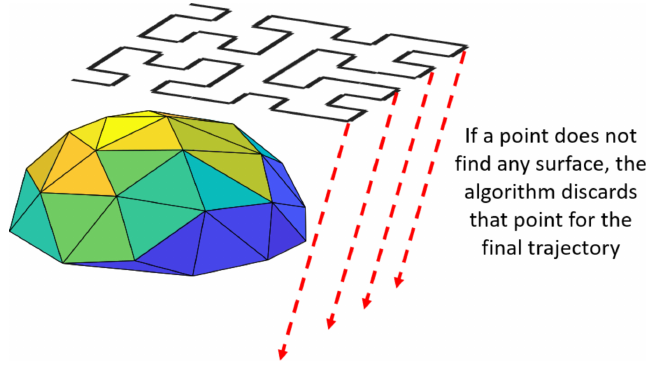
Figure 8. Points are discarded if they never cross any surface.